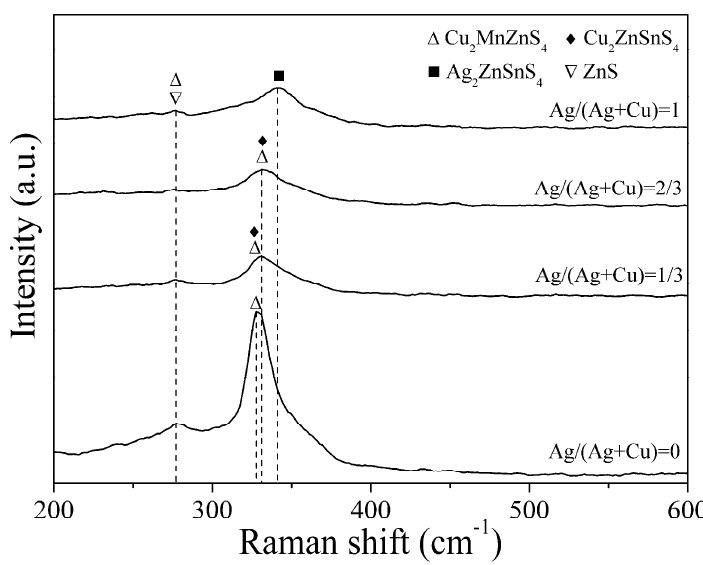
Figure 3. Raman spectra of Ag and Mn co-doped Cu 2 ZnSnS 4 thin films with different Ag/(Ag + Cu) ratios.